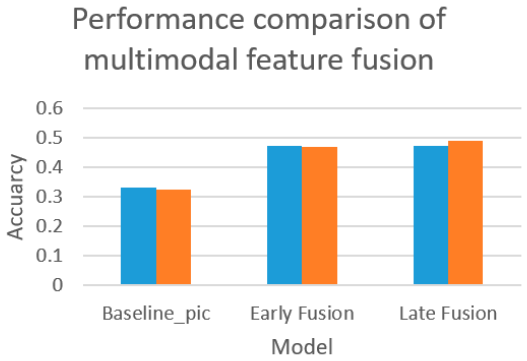
Figure 9. The performance comparison of early and late fusions.